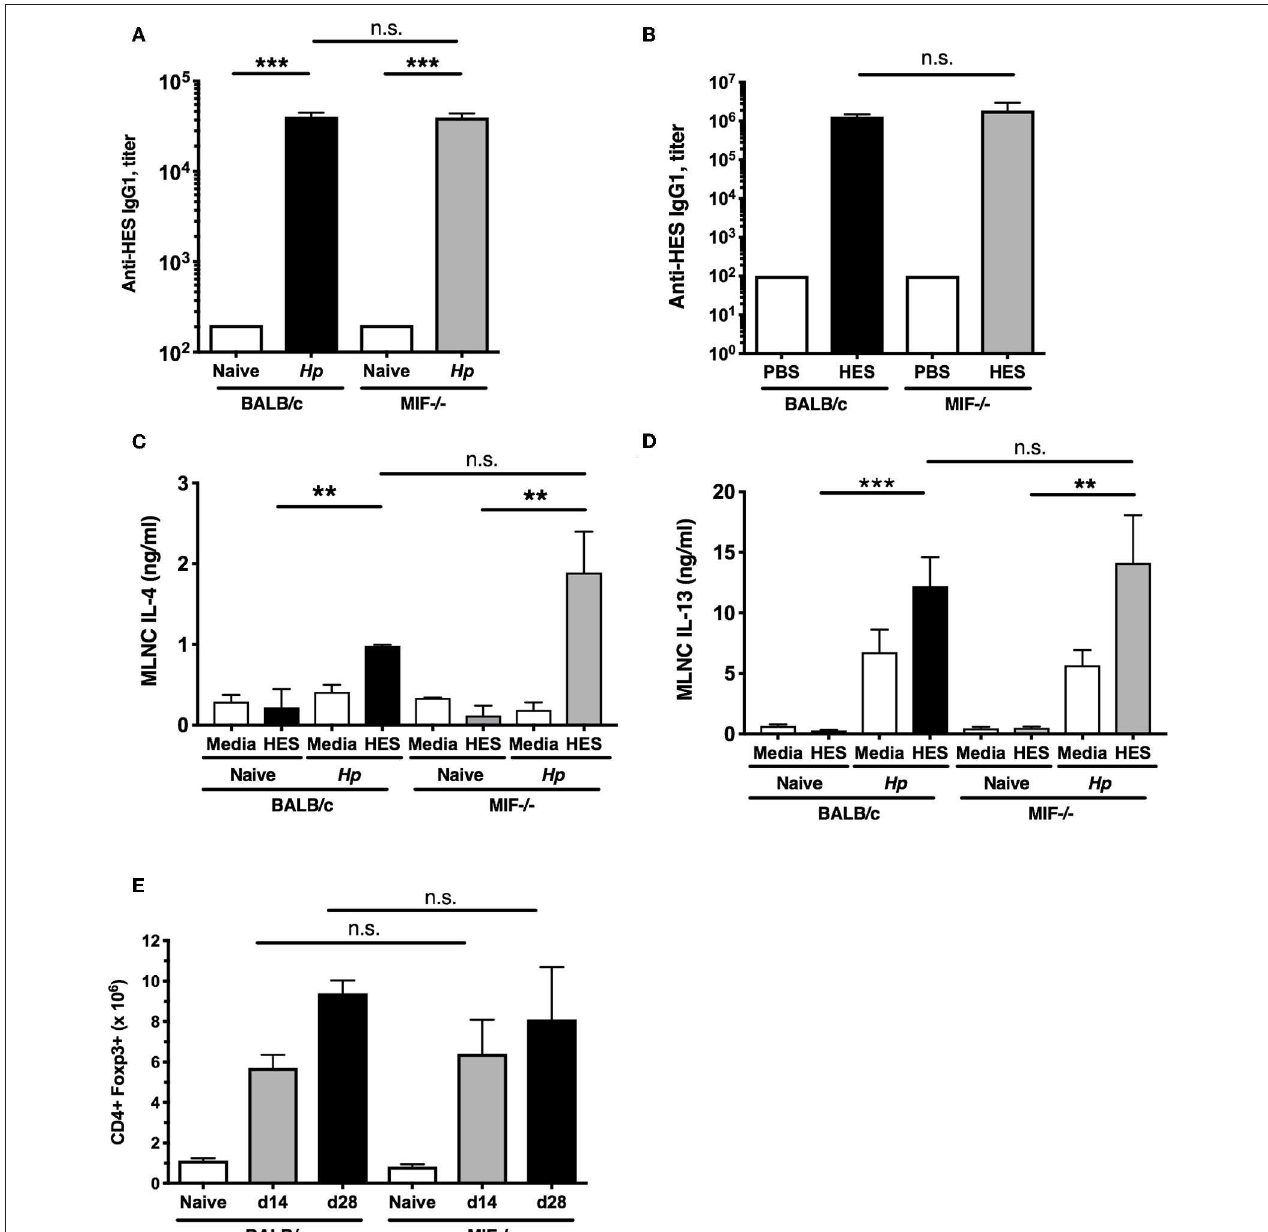
FIGURE 2 | Intact adaptive and regulatory responses in MIF-deficient mice. (A) Comparable anti-helminth humoral immunity in BALB/c and MIF − / − mice. Titers of HES-specific IgG1 serum antibodies from naïve and day 28-infected BALB/c and MIF − / − mice, assessed by ELISA. Data are representative of two independent experiments. (B) Comparable anti-helminth humoral immunity in HES-vaccinated BALB/c and MIF − / − mice. Parasite-specific antibody responses in vaccinated BALB/c and MIF − / − mice. HES-specific serum IgG1 levels were measured by ELISA on the day of challenge infection. Data are representative of two independent experiments. (C,D) Comparable adaptive type 2 immune responses in BALB/c and MIF − / − mice. Th2 cytokines from culture medium of MLNC from naïve and day 14 H. polygyrus -infected BALB/c and MIF − / − mice, restimulated with 1 µ g/ml HES or media for 72 hours. Levels of IL-4 (C) and IL-13 (D) were measured by ELISA. Data are representative of two independent experiments. (E) Regulatory cell induction by helminth infection is comparable between BALB/c and MIF − / − mice. Numbers of CD4 + Foxp3 + Treg cells within MLNs from BALB/c and MIF − / − mice at days 14 and 28 post-infection with H. polygyrus . Data are representative of two independent experiments. n.s., not significant, ** p < 0.01, *** p < 0.001.